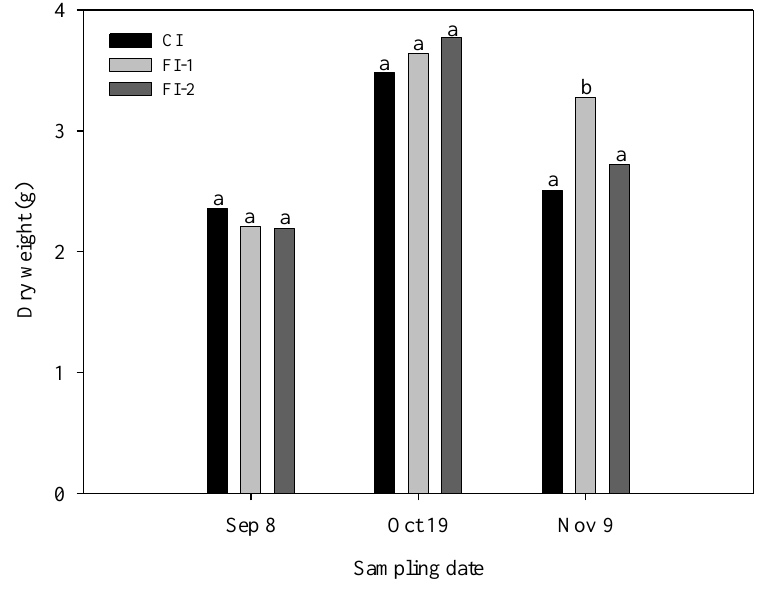
FIGURE 5. Comparisons of dry weight of leaf blade among treatments at different sampling dates. Different letters at the top of the bars indicate significant difference ( p <